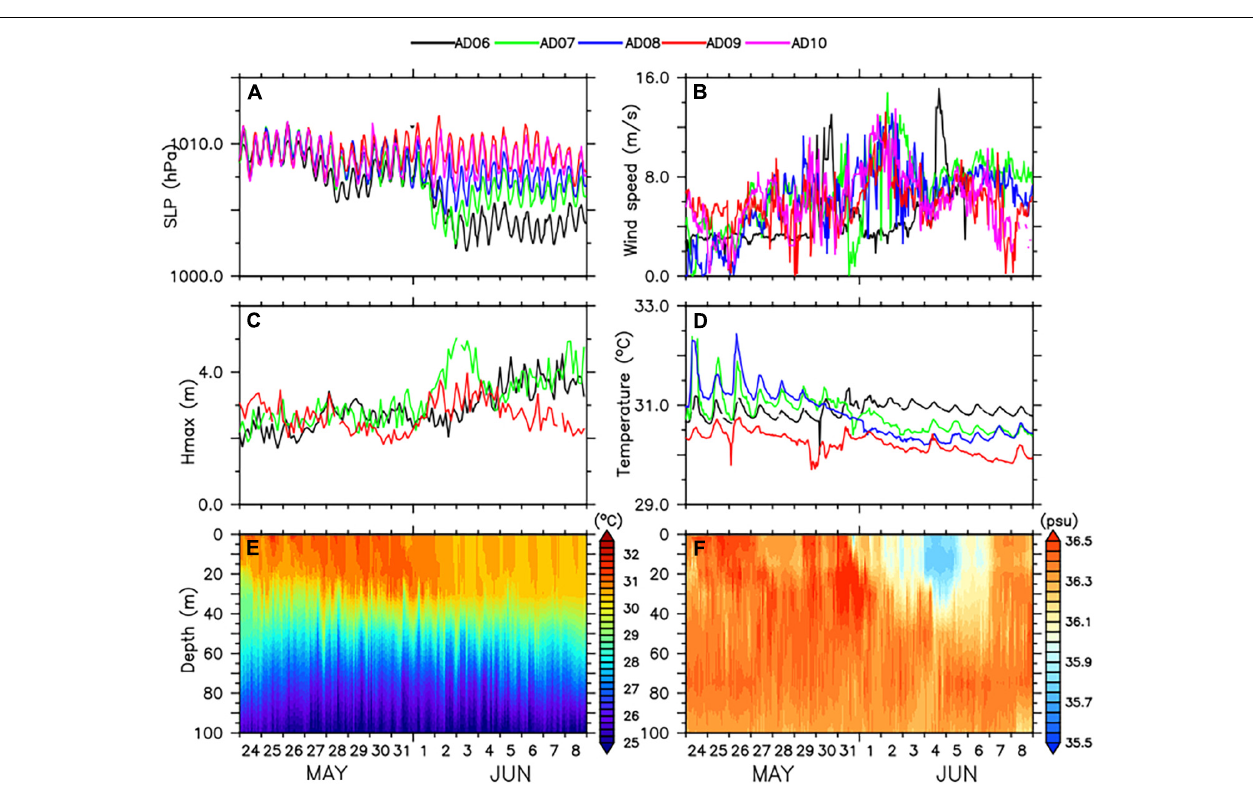
FIGURE 7 | The tracks of the cyclones (A) Amphan, (B) Nisarga, and (C) Nivar during the year 2020 in the north Indian Ocean along with the moored buoy network.